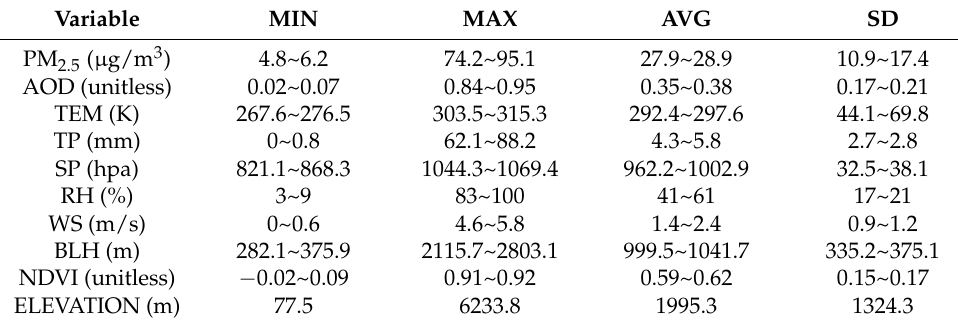
Table 2. Results of descriptive statistical analysis of variables.